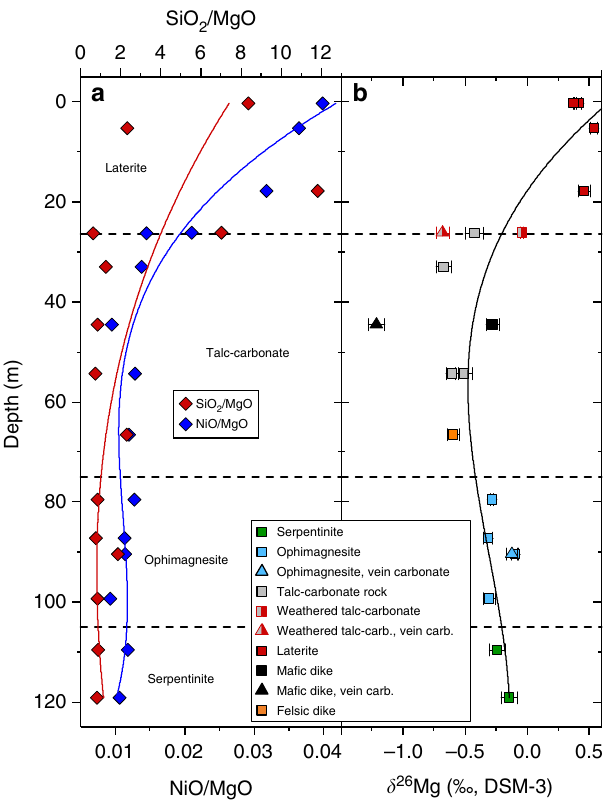
Fig. 6 Bulk rock chemical changes in drill core through weathered and hydrothermally altered peridotite. Distinct changes in a NiO/MgO and SiO 2 /MgO and b δ 26 Mg in laterite and talc-carbonate altered serpentinite from the SGC are indicative of open system alteration. Mg depletion in the laterite accompanied by increasing δ 26 Mg is related to preferential breakdown of magnesite during weathering, whereas deviation of δ 26 Mg from the background value (serpentinite) in deeper parts of the pro fi le re fl ects addition of 24 Mg during hydrothermal carbonation. Error bars re fl ect the 2 σ standard deviation. Data are listed in Supplementary Tables 2